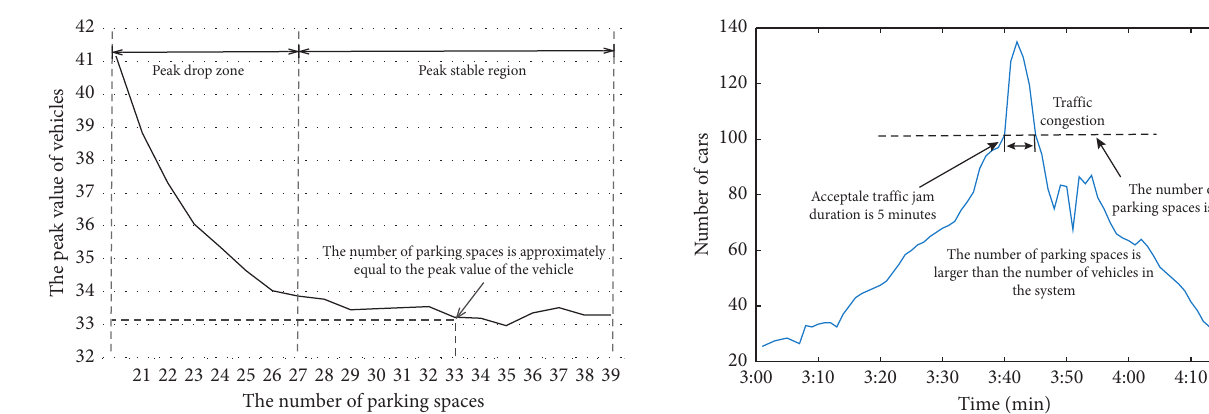
Figure 5: The average peak vehicle number under different parking spaces.